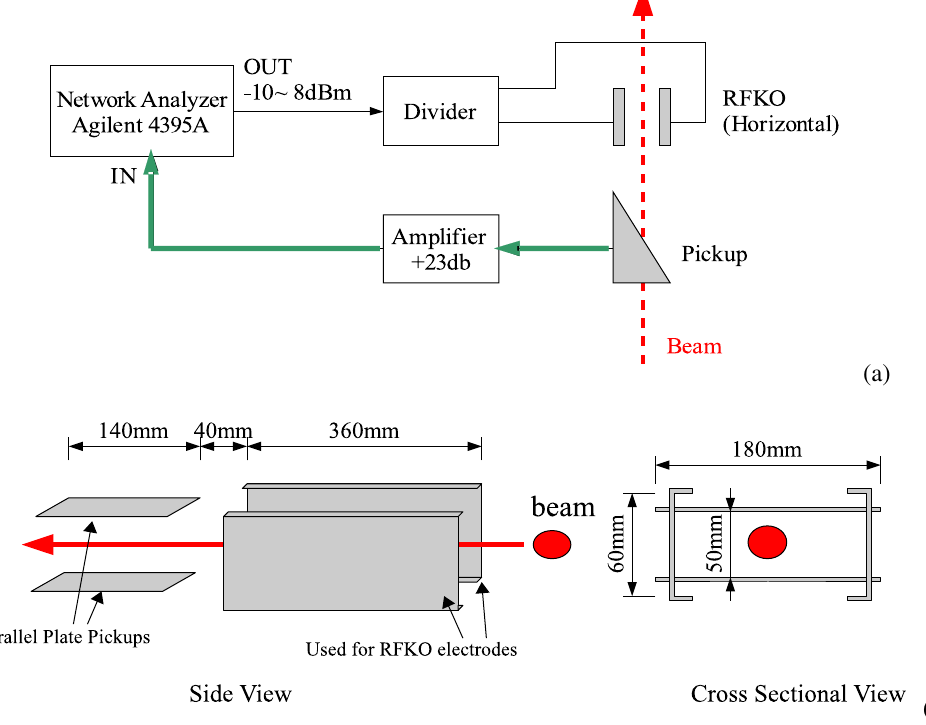
FIG. 5. (a) Block diagram of the betatron tunes and the synchrotron-tune measurement system. A small perturbation is applied to the beam with RFKO. If the applied perturbation frequency is near the synchrotron sideband, the beam fluctuation signal is enhanced, and it is detected with a triangle pickup. (b) Schematic drawing of the horizontal RFKO electrodes and ‘‘Parallel Plate Pickups’’ to measure the beam